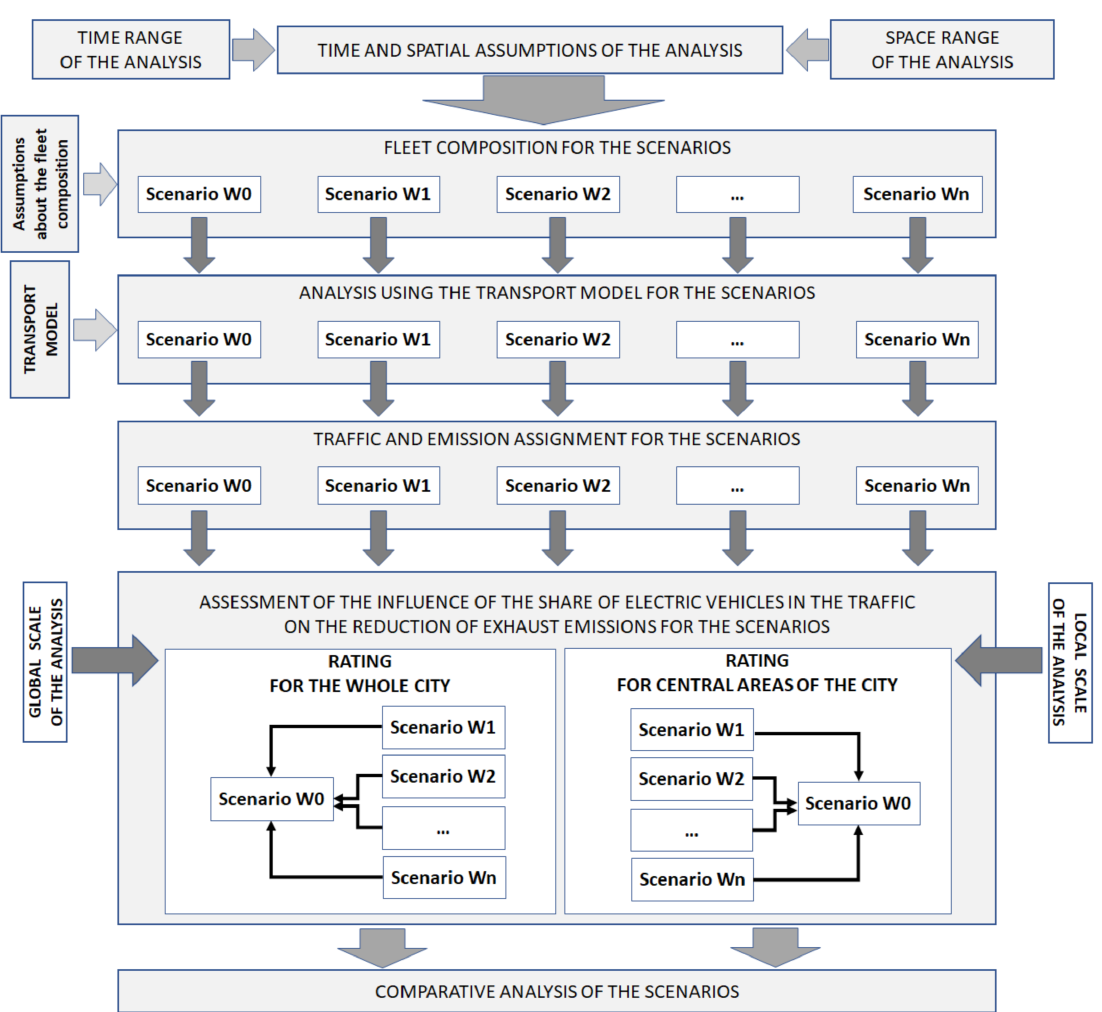
Figure 1. Scheme of the method of the scenario analyses of reducing exhaust emissions by introducing electric vehicles in the